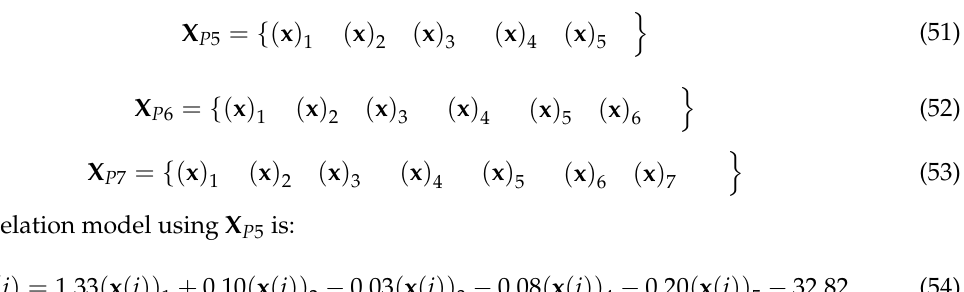
periods are summarized in Table 3.